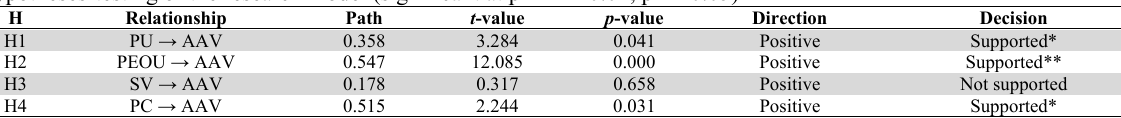
Hypotheses-testing of the research model (significant at p** < = 0.01, p* <